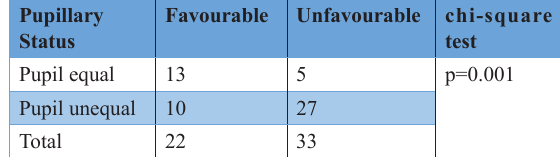
Table 5. Relation between preoperative pupillary status and outcome (chi-square test) Pupillary